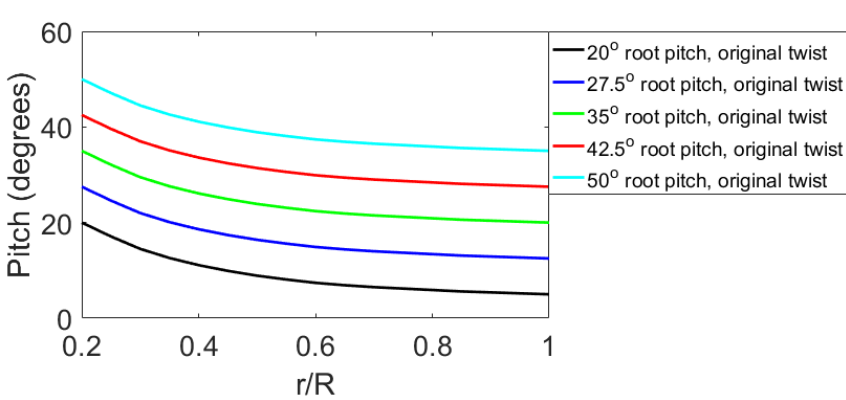
Figure A3. Pitch distribution for original blade at different root pitch